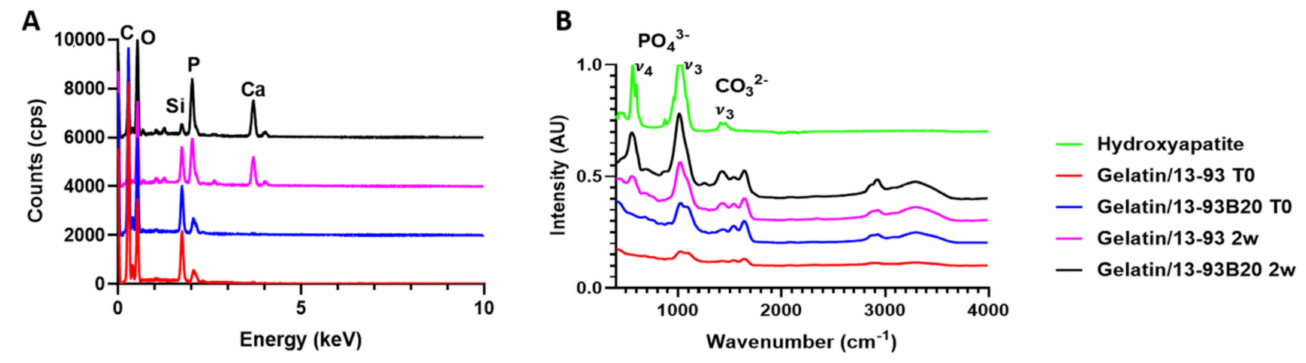
Figure 9. ( A ) EDX analysis of the nodules at the hybrids surface and ( B ) FTIR analysis of the samples surfaces before and after 14 days of